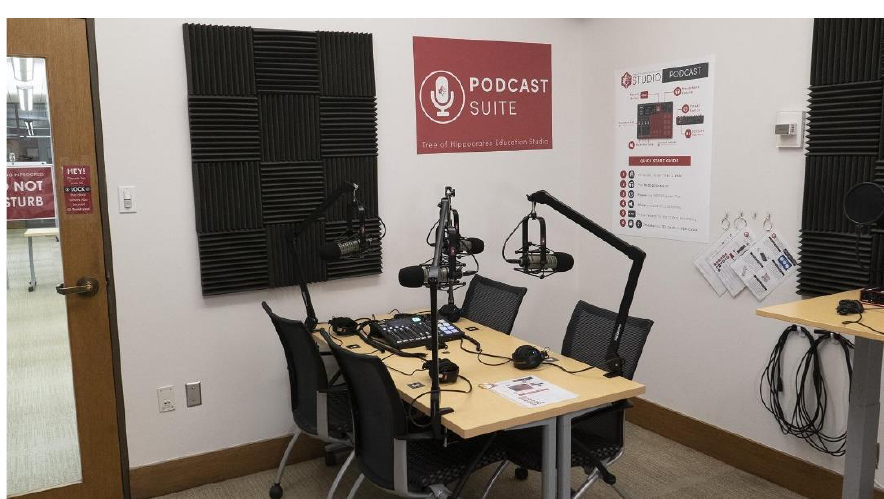
Figure 2 The Podcast Suite inside THE Studio, a multimedia recording